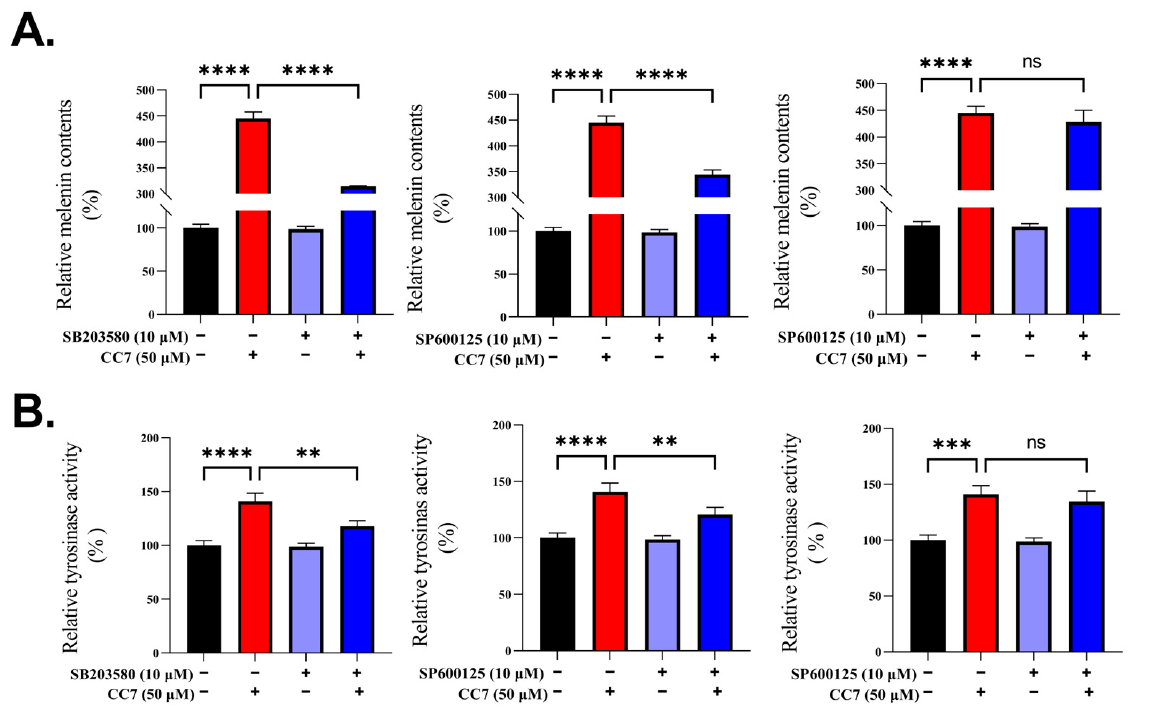
Figure 5. CC7 enhances the melanogenesis not affected by MAPKs in B16 cells. Effects of CC7 and in the presence or absence of PD98059, SP600125, and SB203580 on melanin content (%) ( A ) and tyrosinase activity (%) ( B ) in B16 cells after 48 h. Each value is presented as the mean ± SD. ** p < 0.01, *** p < 0.001 and **** p < 0.0001 compared with NC (negative control) group. ns: no statistical significance.